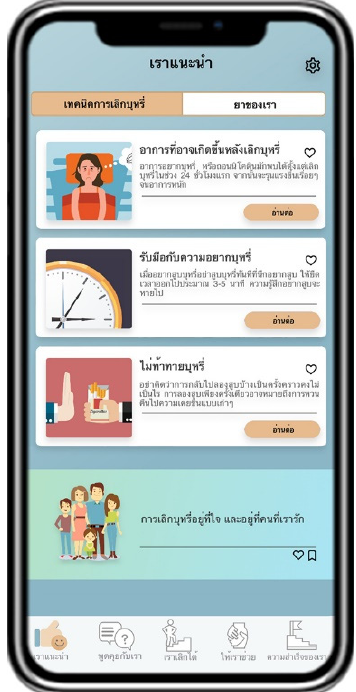
Figure 2. Display screen of Suggested by US.